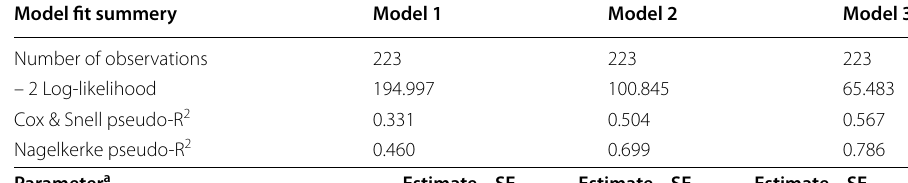
Table 4 Model estimation results 1 (LOGIT): dependent variable